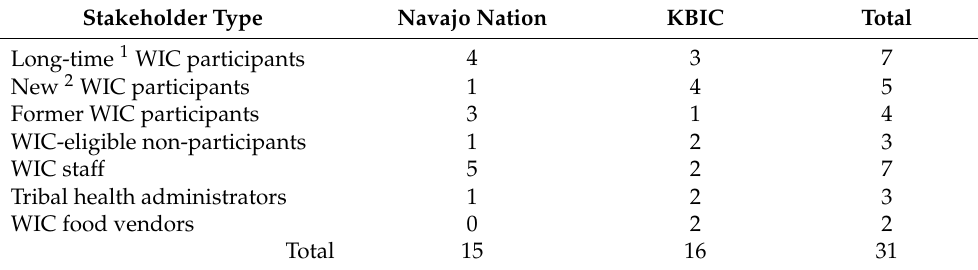
Table 1. In-depth interviews conducted, by stakeholder type and WIC program